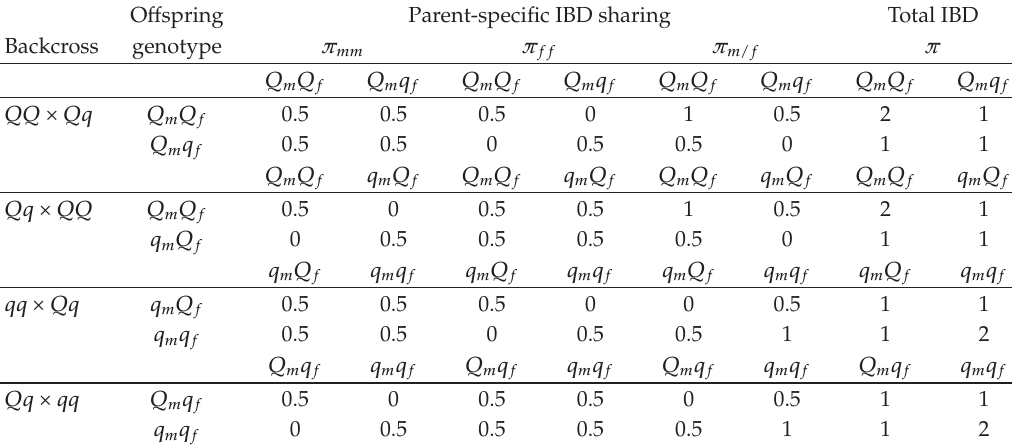
Table 1: The IBD sharing coe ffi cients for full-sib pairs in a reciprocal backcross design considering allelic parental